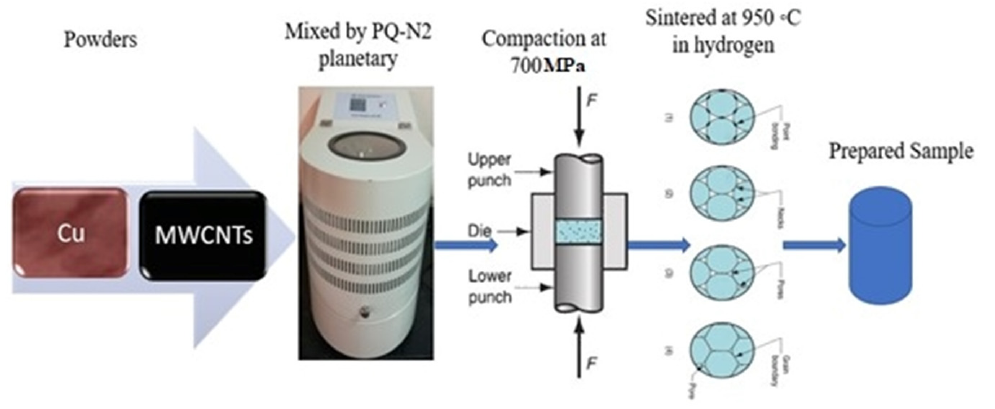
Figure 2. The preparation and fabrication process of the samples.